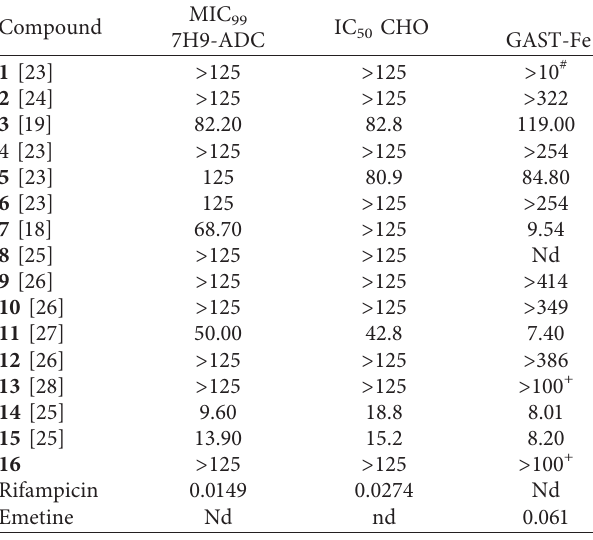
Figure 1: Structures of evaluated compounds grouped according to the respective lipophilic scaffold. Table 1: Antimycobacterial activity and cytotoxicity